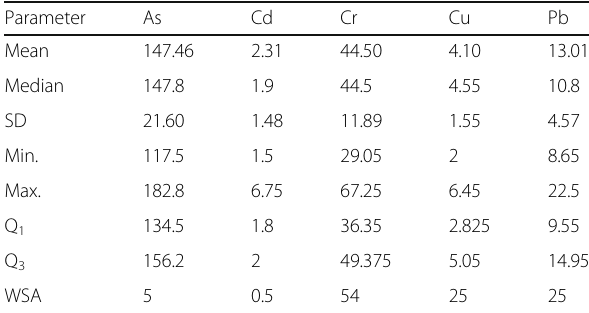
Table 3 Summary statistics of heavy metals (mg/kg) compared with the average of worldwide soil